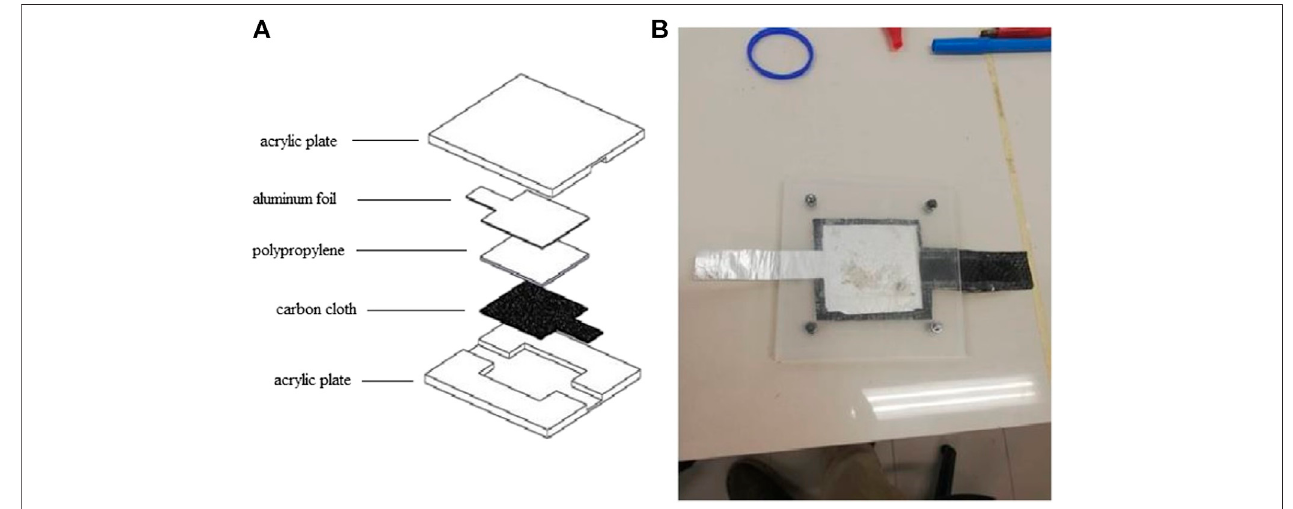
FIGURE 1 | (A) Conceptual design of Al-air battery (B) Al-air battery prototype.